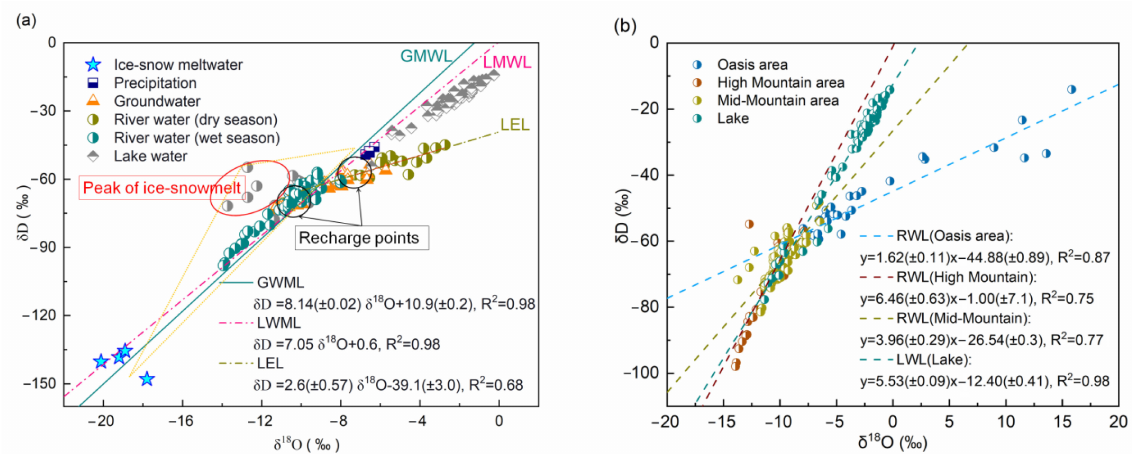
Figure 4. ( a ) Water component relationships displayed by the bivariate plot of δ D versus δ 18 O in the Kaidu River Basin, river water, precipitation, ice and snow melt and groundwater relative to GMWL. ( b ) River water samples from the high mountain area, mid-mountain area, oasis area and lake. (GMWL: global meteoric water line; LMWL: local meteoric water line; LEL: local evaporation line; RWL: river water line; LWL: lake water line). Both the slopes and the intercepts of the four regression lines presented in ( b ) are statistically different from each other (Tukey’s multiple comparison test).